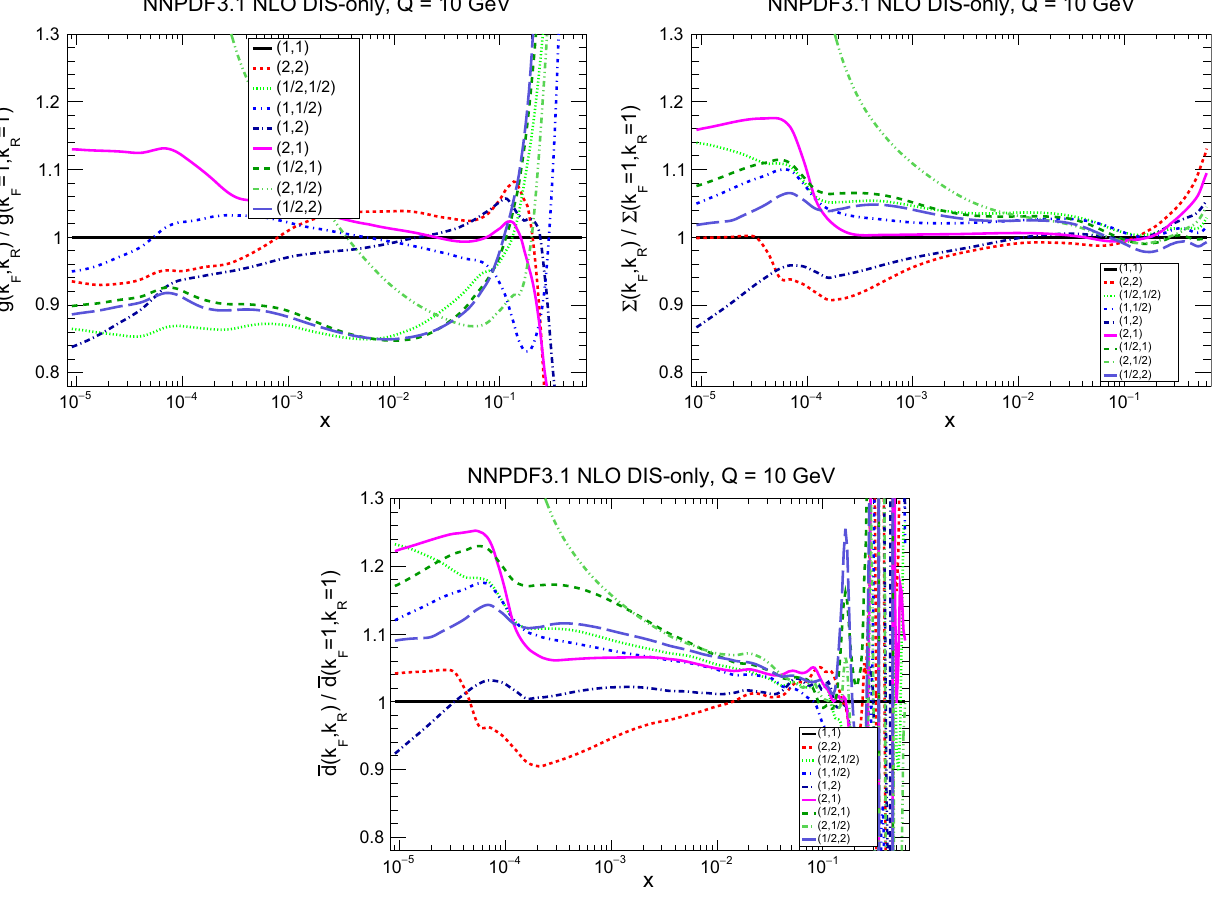
Fig. 24 Comparison of the central values of the DIS-only PDF with different values of ( k f , k r ) . All results are normalized to the baseline ( k , k ) = ( 1 , 1 ) . The gluon, the total quark singlet and down antiquark (top to bottom) are shown at Q = 10 f r